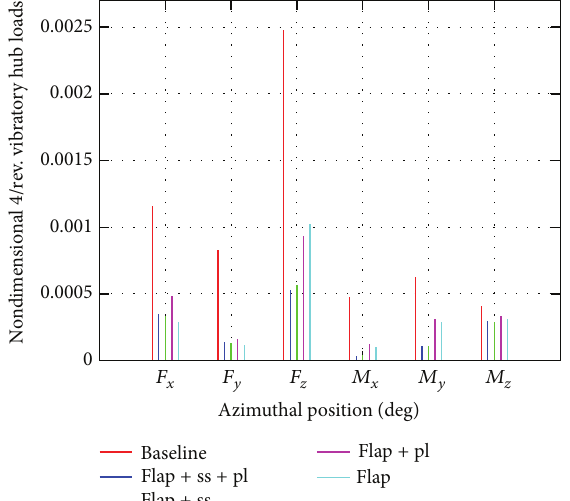
Figure 12: Flap deflections harmonics.